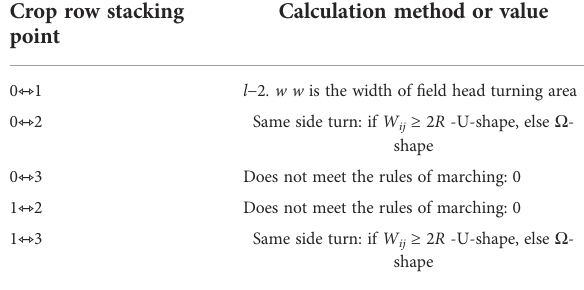
TABLE 2 Differences in the number of turns in the long and short side branches of the fi eld.